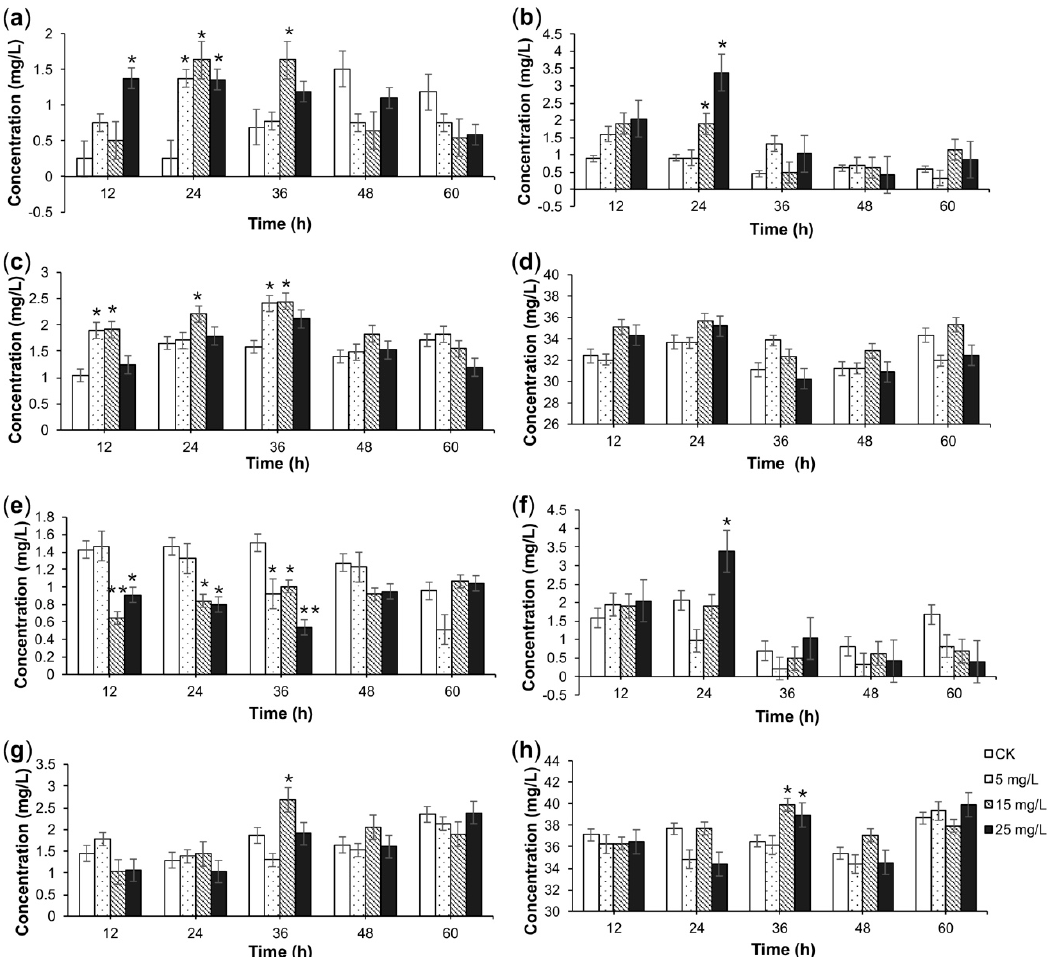
Figure 3. The effect of the A. flavus medium elicitor on the concentrations of TIAs. The effect of the A. flavus medium elicitor on the concentrations of vindoline ( a ), catharanthine ( b ), ajmaline ( c ), and total alkaloids ( d ) in four-day-old suspensions of C. roseus CMCs. The effect of A. flavus medium elicitor on the concentrations of vindoline € , catharanthine ( f ), ajmaline ( g ), and total alkaloids ( h ) in six-day-old suspensions of C. roseus CMCs. C. roseus CMC cultures treated by sterile water were labeled as the check group (CK). Data are given as the means ± SD ( n = 3). * p < 0.05, ** p < 0.01, compared to the CK group.